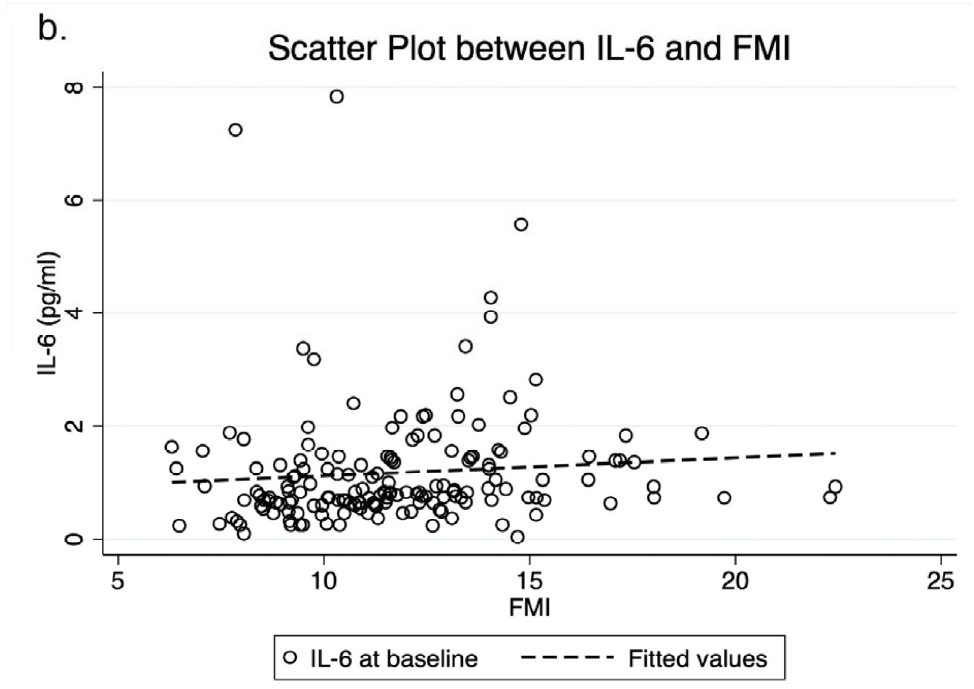
Figure 2. The relationship of IL-6 with body fat percentage ( a ), and FMI ( b ). IL-6 was positively correlated with body fat percentage and FMI (r = 0.29, p = 0.008 and r = 0.25, p = 0.049, respectively) by Spearman correlation coefficients. FMI, fat mass index; IL,